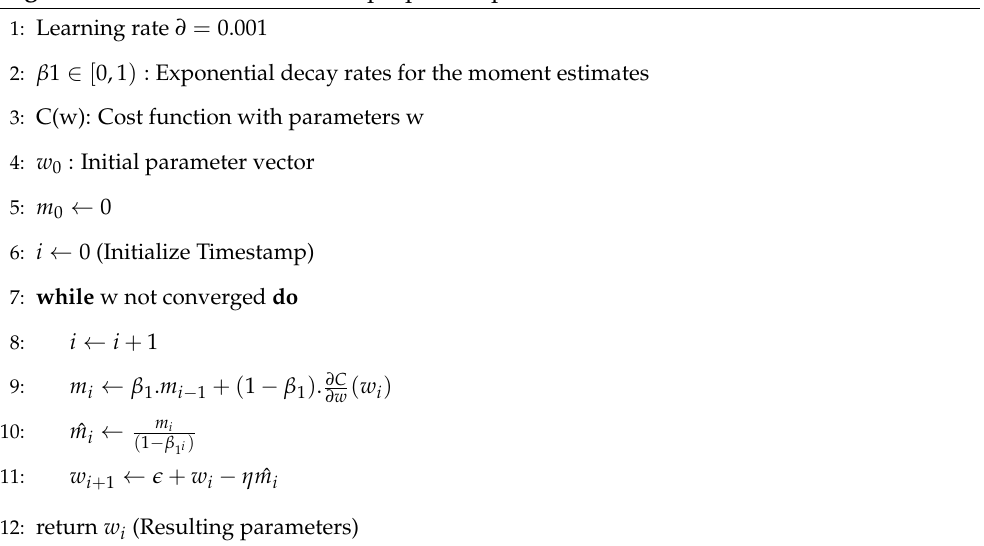
Algorithm 1 Pseudo-code for the proposed optimizer method